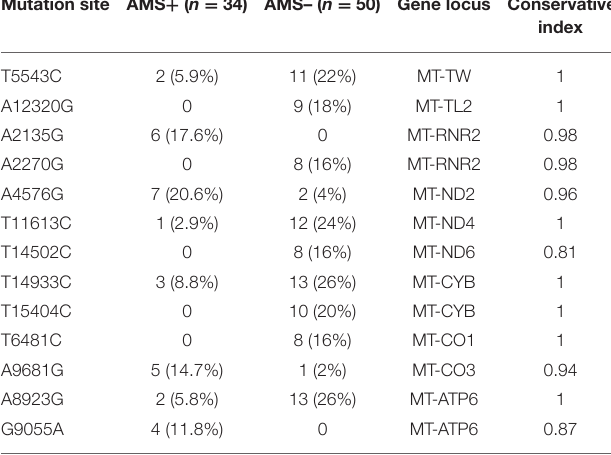
TABLE 9 | Mutation sites with conservation index ≥